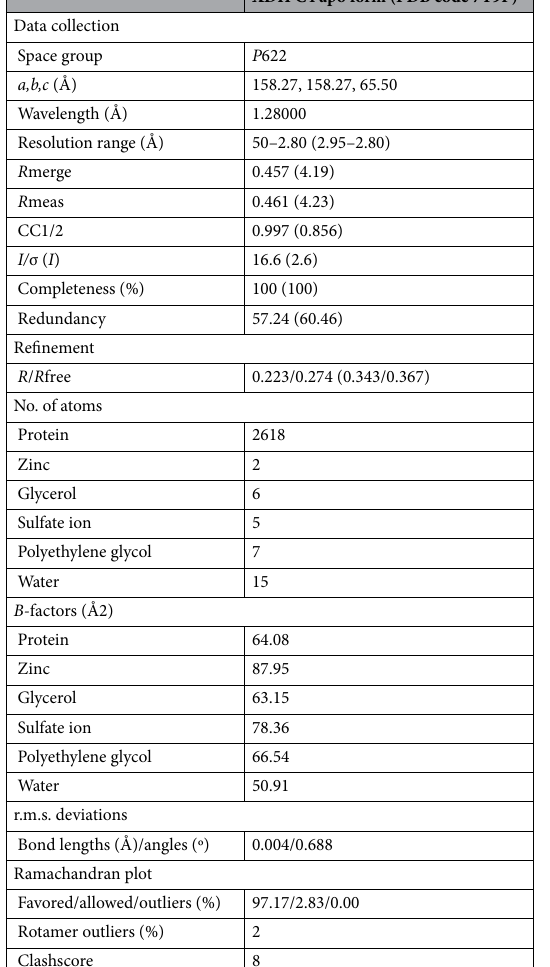
Table 1. Data collection and refinement